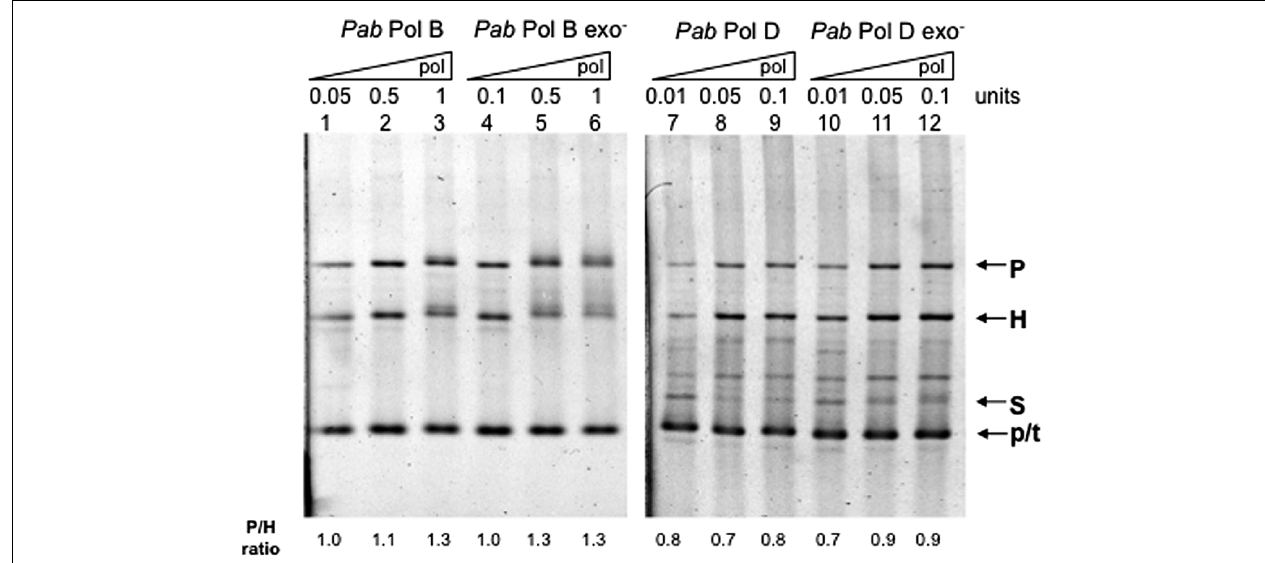
FIGURE 3 | Effect of DNA polymerase concentration on Pab DNA polymerase slippage. Primer extension reactions were carried out as described in the “Materials and Methods” using increasing amounts of the appropriate Pab DNA polymerase. One polymerase unit represents